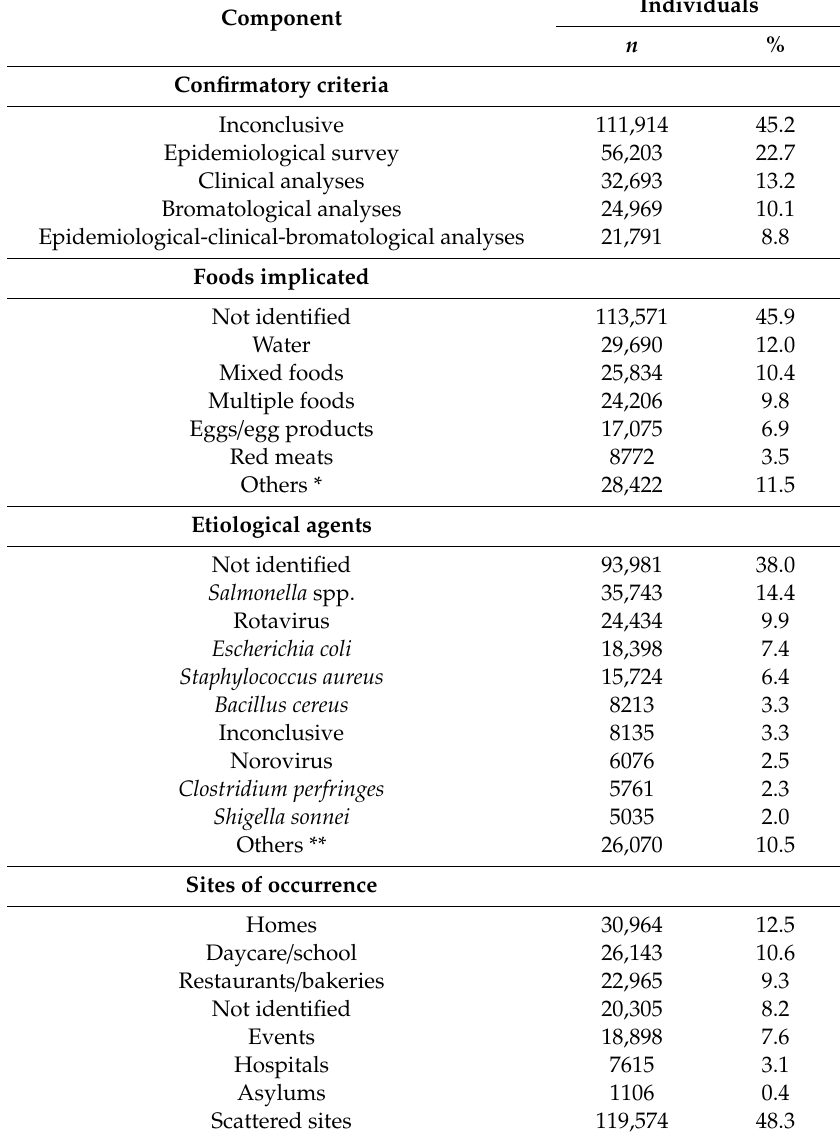
Table 2. Confirmatory criteria, foods implicated, etiological agents, and sites of foodborne disease occurrence in Brazil between 2000 and